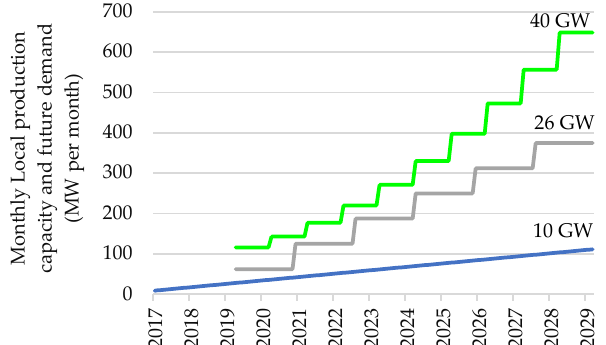
Figure 5. Saudi projected PV supply in MW/month by local manufacturers BAU (blue) (simulated using data from [12]), REPDO supported plan (grey) [27] and calculated required PV production capacity (demand) based on global trend (green).